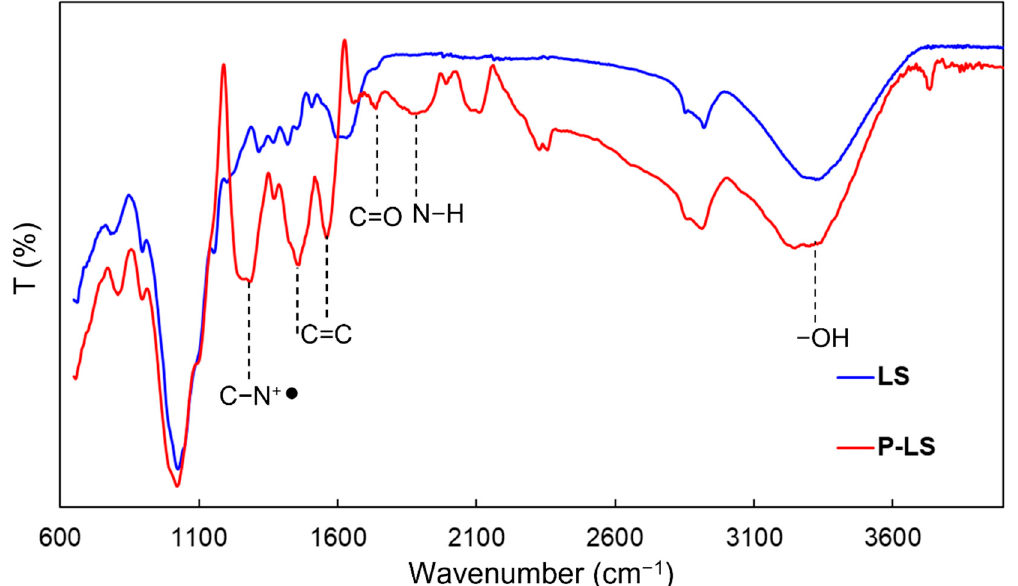
Figure 2. ATR FT − IR spectra of LS and P − LS.